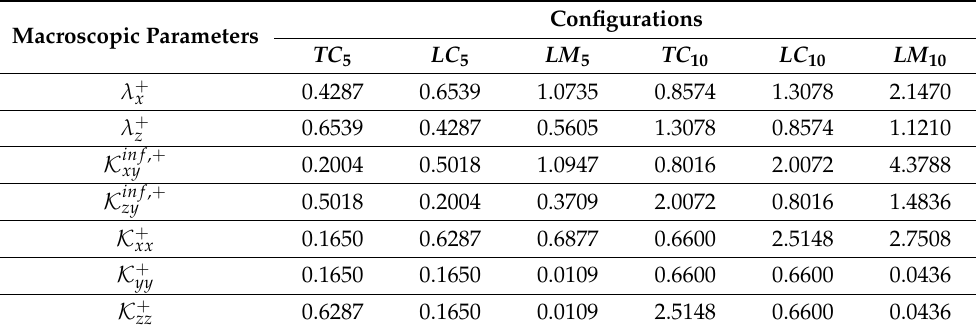
Table 2. Values of the macroscopic coefficients for the different configurations of the porous substrate, given in wall units with Re τ ≈ 190. Macroscopic